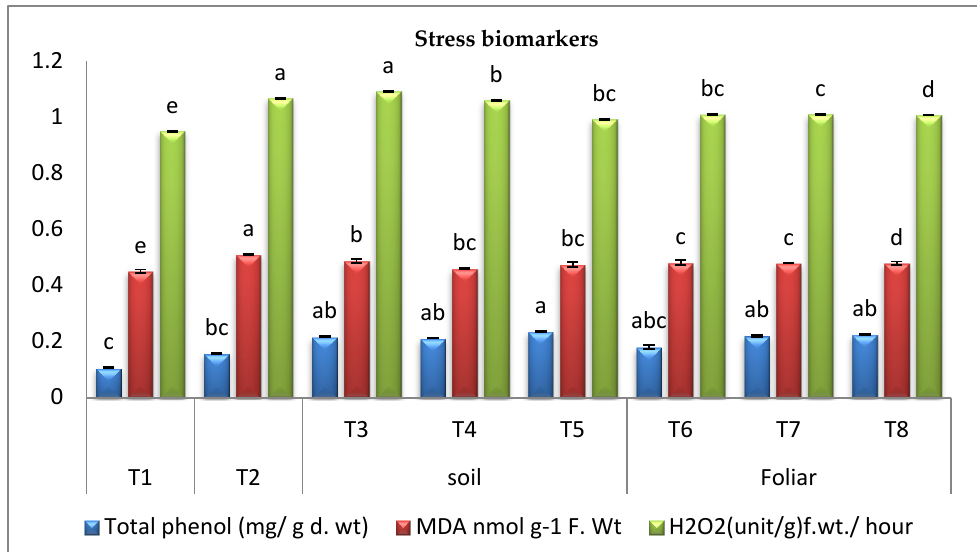
Figure 4. Effect of cyanobacteria on total phenol, Malondialdehyde (MDA), and H 2 O 2 contents of infected pepper plants (T1-healthy control, T2-infected control, T3-infected plants treated with D. muscorum soil, T4-infected plants treated with A. oryzae soil, T5-infected plants treated with A. platensis soil, T6-infected plants treated with D. muscorum foliar spray, T7-infected plants treated with A. oryzae foliar spray and T8-infected plants treated with A. platensis foliar application.) (Data represent mean ± SD, n = 3), (a–d Letters revered to significant in statically analysis).